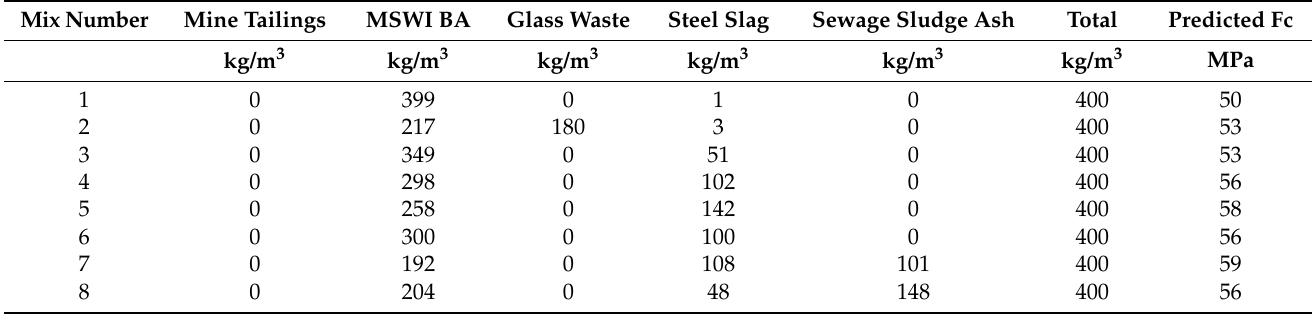
Figure 4. Optimal mixes with alternative materials in Finland. Table 3. Selected optimal mixes using only alternative materials in Belgium.